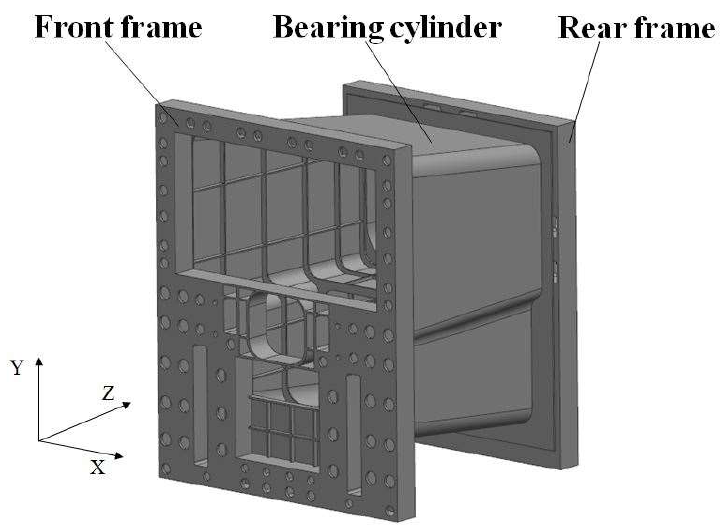
Figure 5. Support structure made of carbon-fiber-reinforced